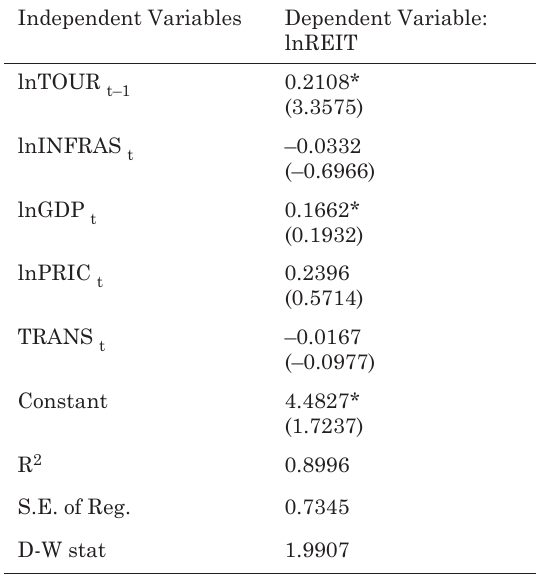
table 3. Regression results of fixed